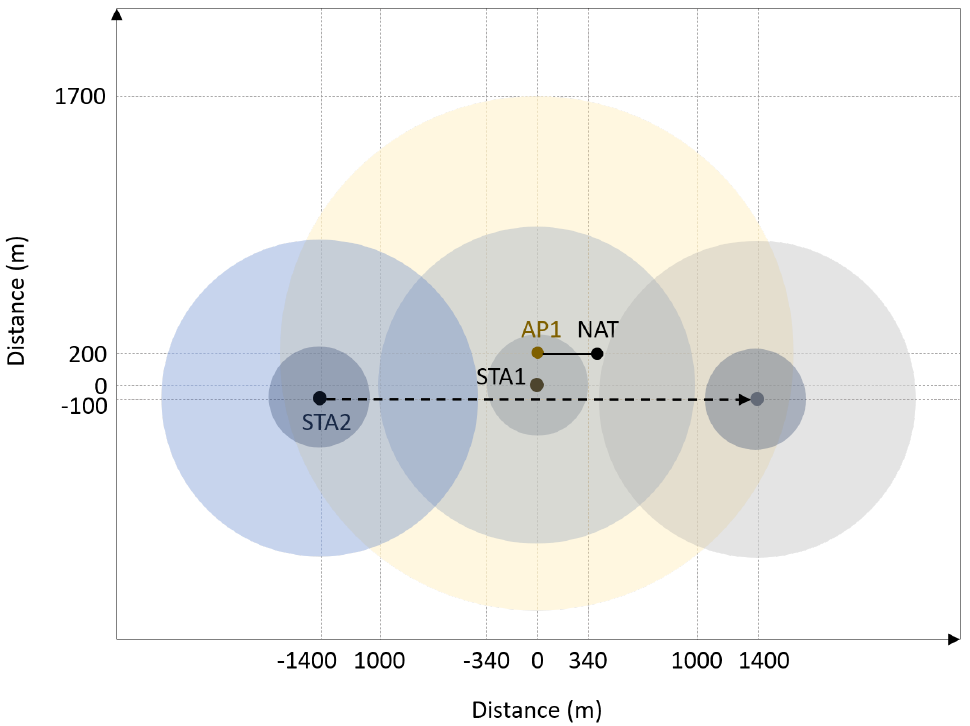
Figure 7. Visualization of the emulated network in communication bootstrapping evaluation, including mesh (small dark circle) and HaLow (larger dark circle) range of